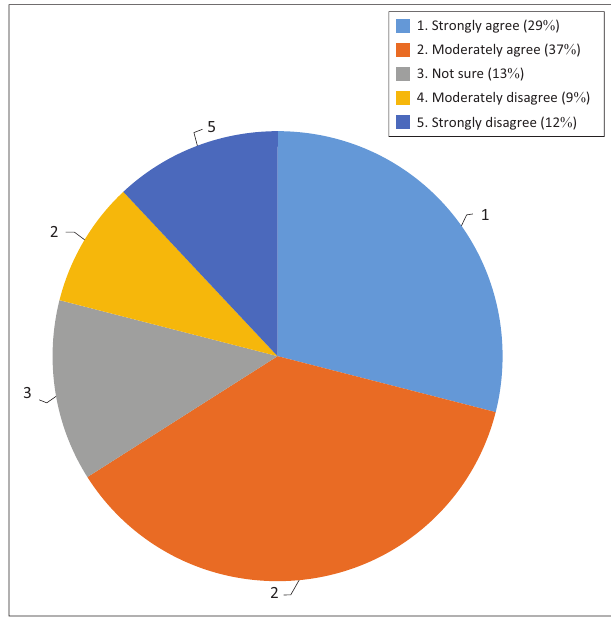
FIGURE 5 : Balance between short- and long-term adaptation scenarios.